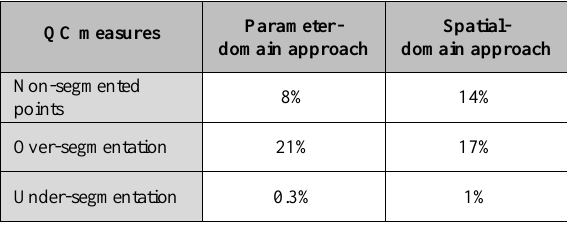
Table 1. Derived quality control measures for the parameter- domain and spatial-domain segmentation results of the airborne laser scanning